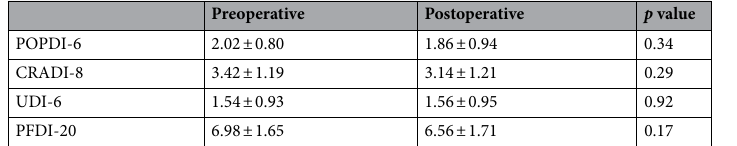
Table 3. Comparison of PFDI-20 before and after surgery in NOSES group of patients. PFDI-20 is made up of those three parts: Pelvic organ prolapse distress inventory 6 (POPDI-6); Colorectal, anal distress inventory 8 (CRADI,8); Urinary distress inventory 6